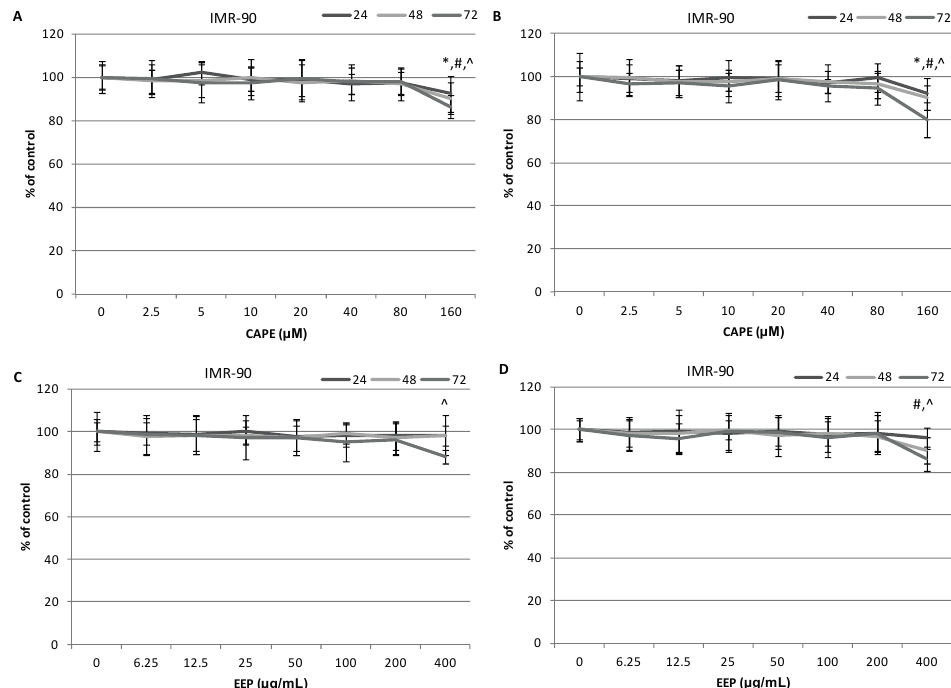
Figure 3. Cytotoxic effects of EEP and CAPE on the normal lung fibroblast IMR-90 cell line. Cells were incubated with 6.25–200.0 μ g·mL − 1 EEP or with 2.5–80.0 μ M CAPE for 24, 48 and 72 h. The values represent the mean ± SD of three independent experiments performed in quadruplicate ( n = 12). ( A ) Cytotoxic activity of CAPE against IMR-90 cells. The percentage of cell death was measured using the MTT cytotoxicity assay. ( B ) Cytotoxic activity of CAPE against IMR-90 cells. The percentage of cell death was measured using the lactate dehydrogenase (LDH) cytotoxicity assay. ( C ) Cytotoxic activity of EEP against IMR-90 cells. The percentage of cell death was measured using the MTT cytotoxicity assay. ( D ) Cytotoxic activity of EEP against IMR-90 cells. The percentage of cell death was measured using the LDH cytotoxicity assay. Results are presented as the means of cytotoxicity ± SD. *, ^ , # indicate statistically-significant differences compared to the control: * after 24 h of incubation, # after 48 h and ^ after 72